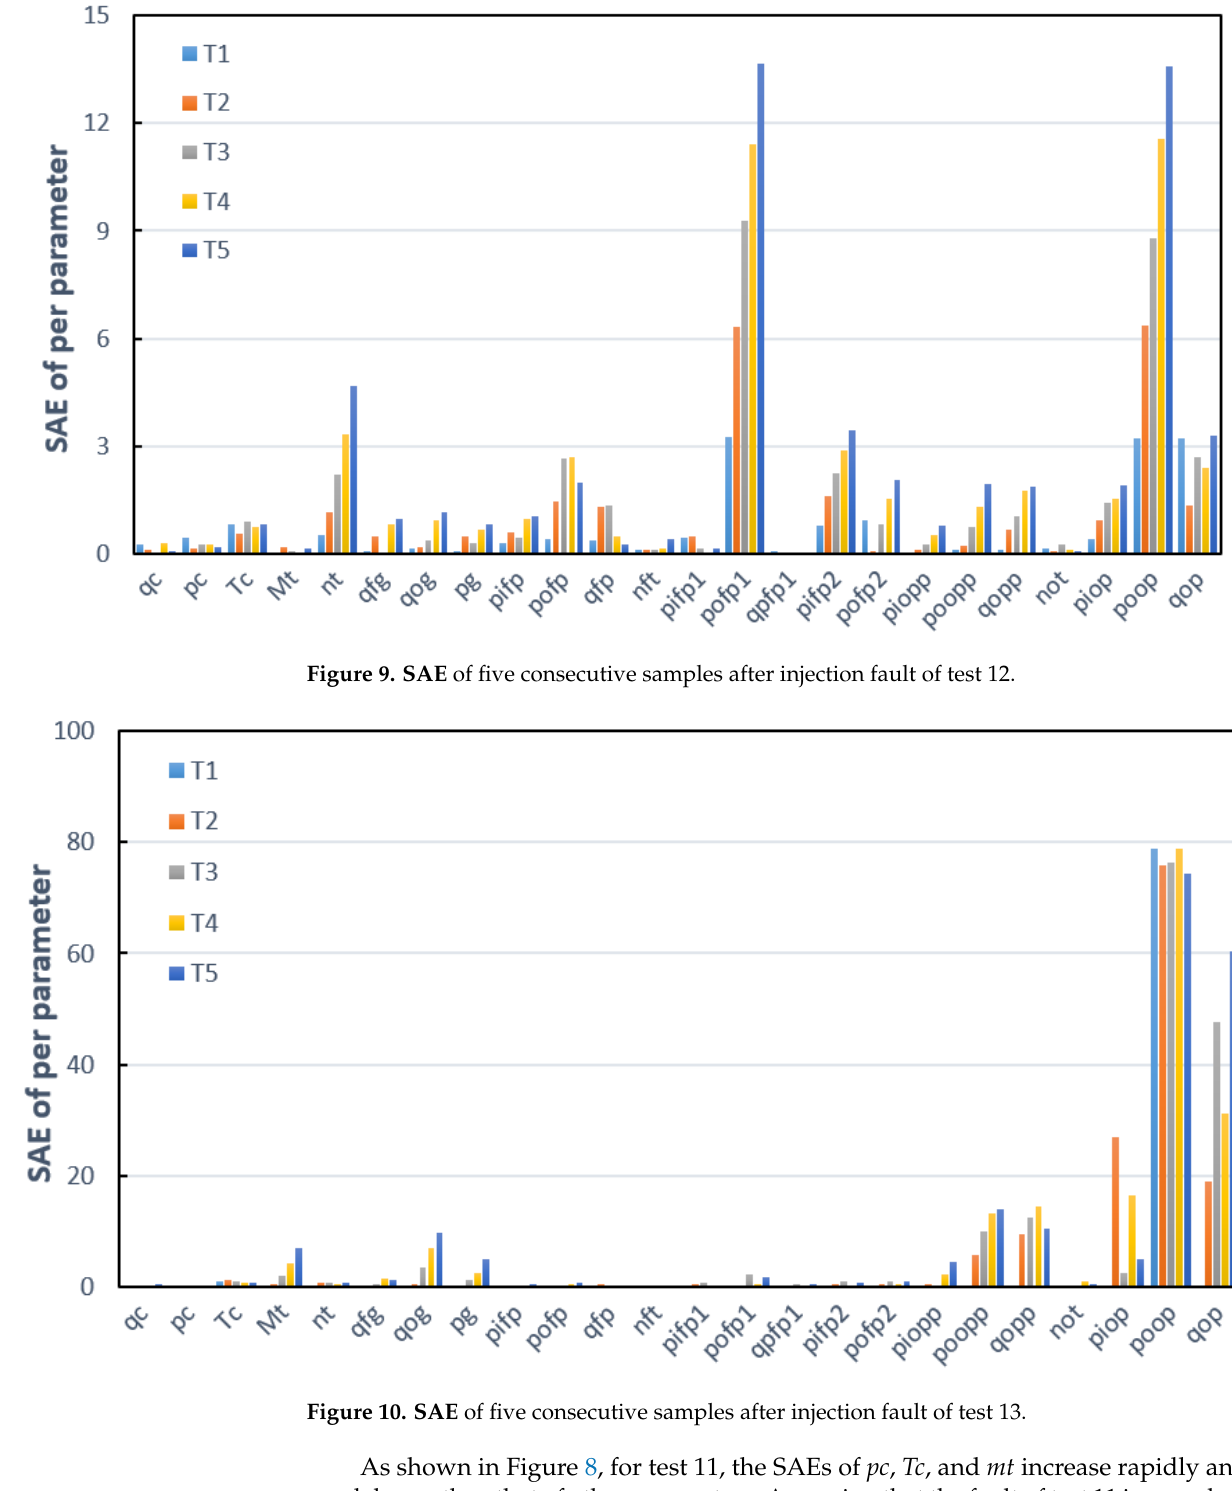
Figure 11. SAE of five consecutive samples after injection fault of test 14. As shown in Figure 8, for test 11, the SAEs of pc , Tc , and mt increase rapidly and are much larger than that of other parameters. Assuming that the fault of test 11 is a com- bustion chamber fault, the SAE of pc and Tc first increases when the combustion cham- ber fails. Then, the failure affected the main turbine directly connected to it, causing the SAE of mt to increase. This process is consistent with the assumption. Therefore, the di-